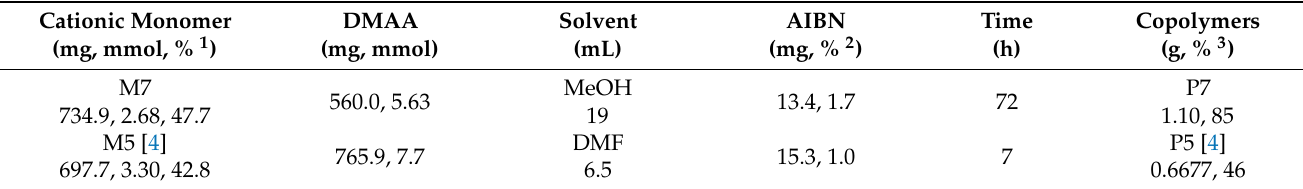
Table 1. Experimental data for the copolymerization of M7 and M5 [4].